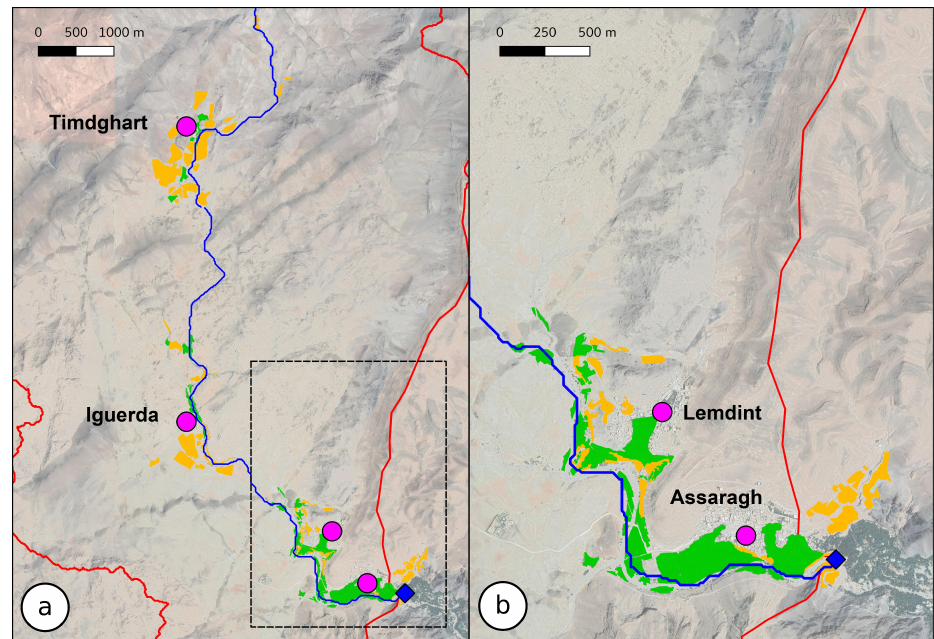
Figure 3. TAS present in the basin: in orange the abandoned terraces, in green the active terraces coinciding almost entirely with the vegetated surface, in deep blue the assif , the circles in magenta are the ksours , the diamond-shaped point in blue is the basin’s outlet, called also amot and in red the watershed boundaries. ( a ) All the terraced systems surveyed inside the basin. ( b ) Focus of the Assaragh TAS, the only one still active in the basin.